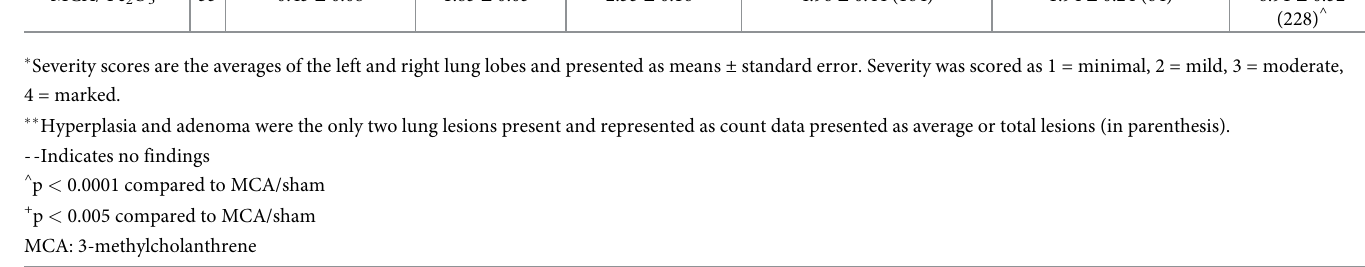
MCA/Fe O , and MCA/Cr O + CaCrO exposure groups. The foreign material appeared as 2 3 2 3 4 multiple, widely scattered individual or small clusters of minute discrete focal aggregates of black granules. In some cases the granules were clearly present within an alveolar histiocyte. In other cases the granules appeared to be within an alveolar histiocyte but the histiocyte was obscured by the granules. Occasionally, granules were scattered within an alveolus and not within a histiocyte. Mild lymphocytic infiltrate was observed in a few MCA/Fe O and MCA/ 2 3 Cr O + CaCrO4—exposed animals, but it was not significantly different than sham. Total 2 3 lung lesions, recorded as the average number of hyperplasias and adenomas per mouse lung, were significantly increased only in the MCA/Fe O3—exposed animals compared to MCA/ 2 sham (6.91 ± 0.52 versus 4.33 ± 0.64, respectively; p < 0.0001).